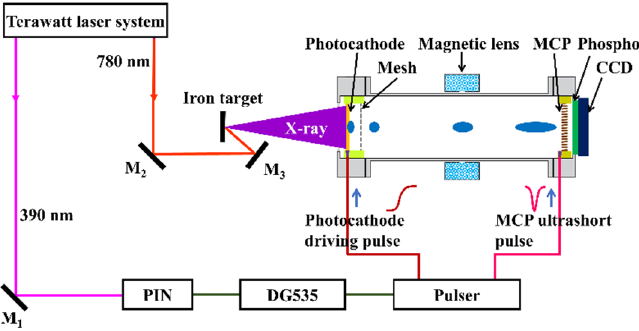
Figure 4. UXI performance measurement experimental device.